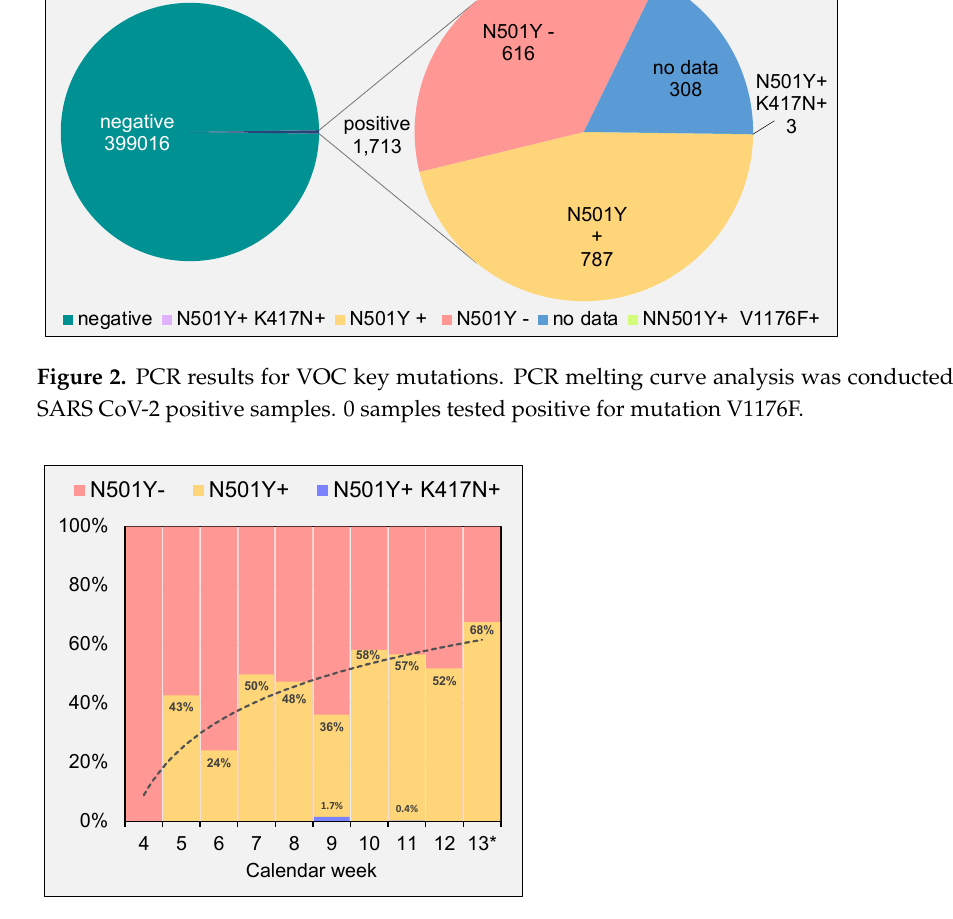
Figure 3. Fraction of key mutations on weekly positive samples. Line represents logarithmic regression for N501Y+ cases (following regression function y = 0.229 ln(x) + 0.0897). * less than 7 days of the indicated week